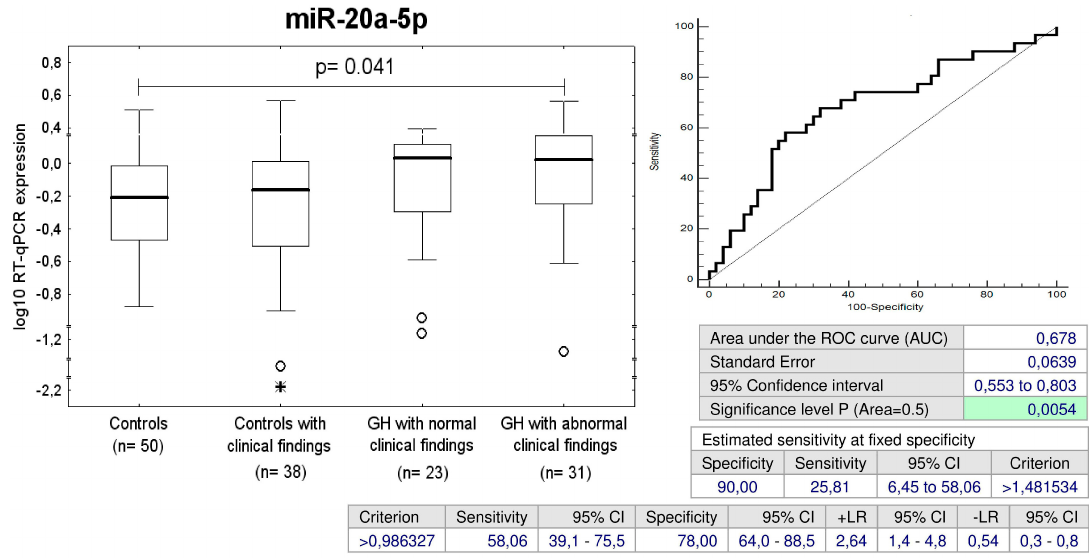
Figure 5. Increased expression of miR-20a-5p in children with abnormal postnatal clinical findings descending from GH pregnancies. Increased expression of miR-20a-5p was found in children with abnormal postnatal clinical findings descending from GH pregnancies.